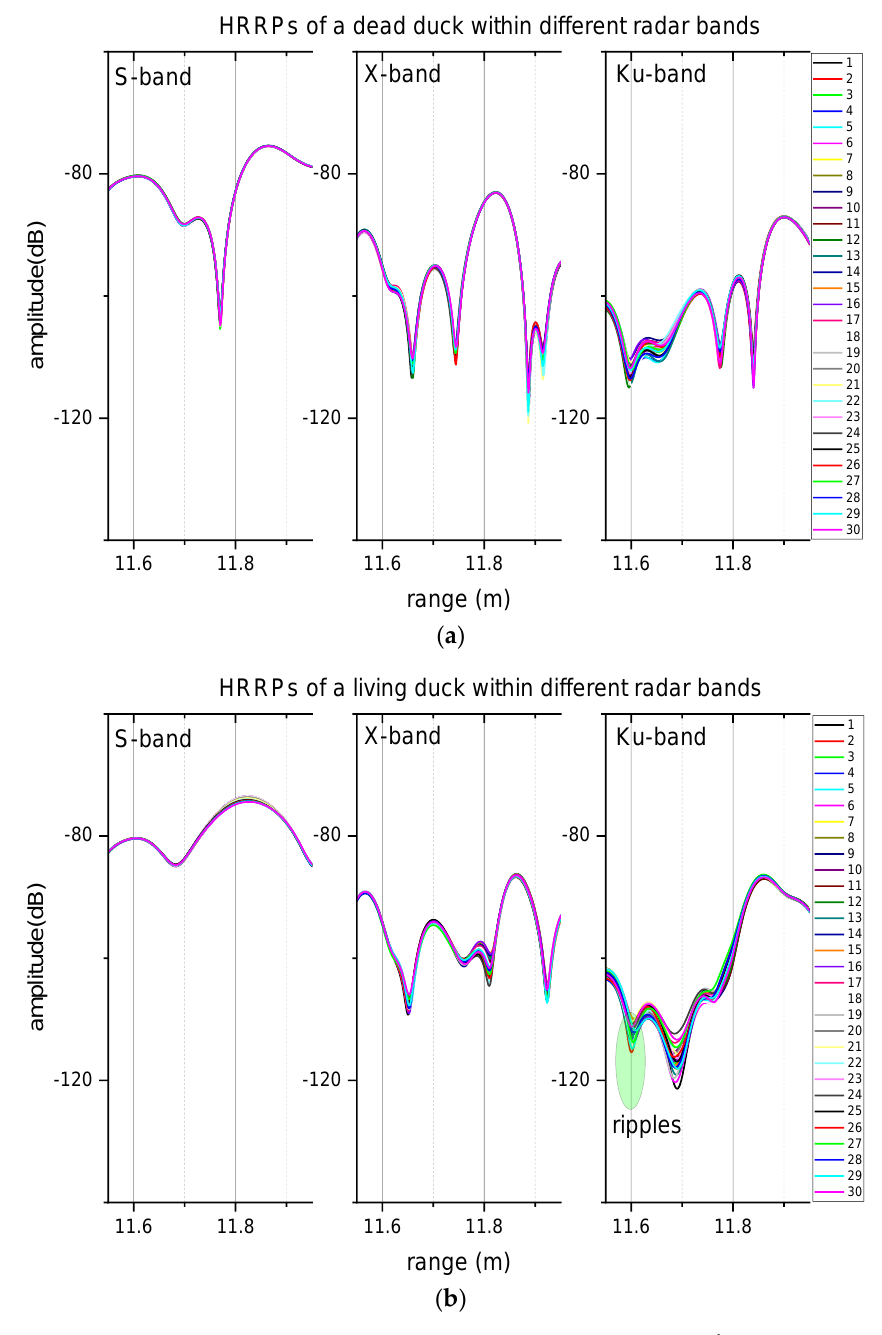
Figure 5. The comparison of HRRPs of a living duck and a dead duck 1 . ( a ) HRRPs of a dead duck, ( b ) HRRPs of a living duck. 1 The ducks were in positions around 11.8 m of the range profiles. Statistical results of both LRRPs and HRRPs are shown in Table 2. The mean value is the mean number, and the scope is the difference between the maximum and the minimum one, which describes the fluctuation level of the signals. First, the mean values of the S-band were the largest, and those of the X-band were the second largest, and then those of the Ku-band were the smallest, no matter whether it was the living duck or the dead duck. Second, the scope level was less than 1 dB within the S-band and approximately 4 dB within the X-band and the Ku-band. Similar to LRRPs, neither was larger than the 10 dB level.